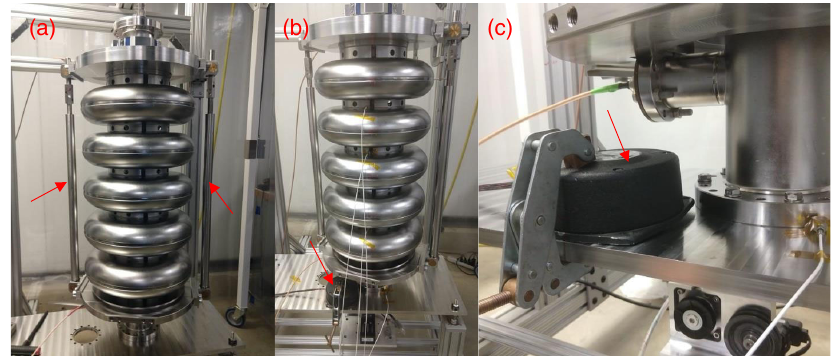
FIG. 7. (a) 644 MHz cavity assembled with the rigid steel bars (arrows) clamped to the ends of the cavity to mimic the presence of the helium jacket. (b) Cavity assembled on the test stand with the mechanical speaker (arrow) in place, with accelerometers (white cables) attached to the cell equators. (c) details of the mechanical speaker coupled to the cavity test